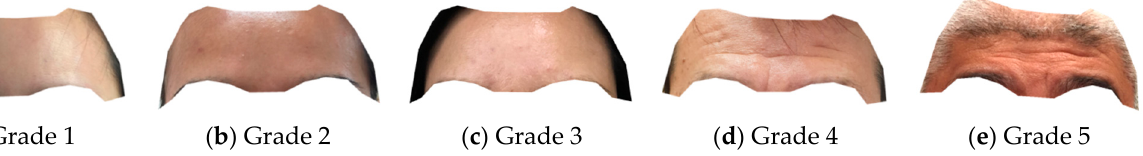
Figure 4. Examples of the five grades of forehead wrinkles (regions are similar to Figure 2b).